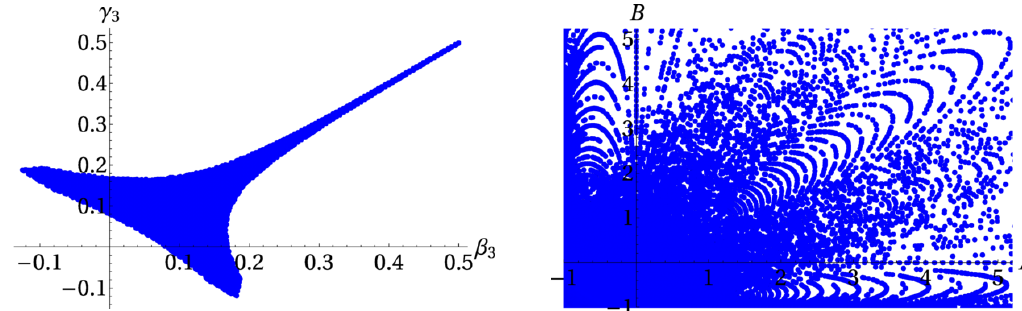
Figure 16. The range of parameters for the AdS-Taub-NUT solutions with two squashings. Left panel : the values of (cid:13) 3 and (cid:12) 3 that lead to regular solutions. Right panel : the resulting values of the squashing parameters A and B .